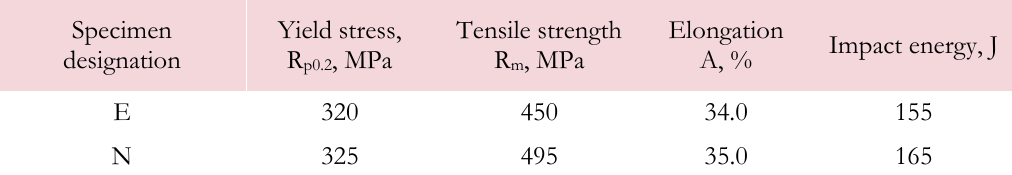
Table 2: Chemical composition of exploited (E) and new (N) PM specimens.